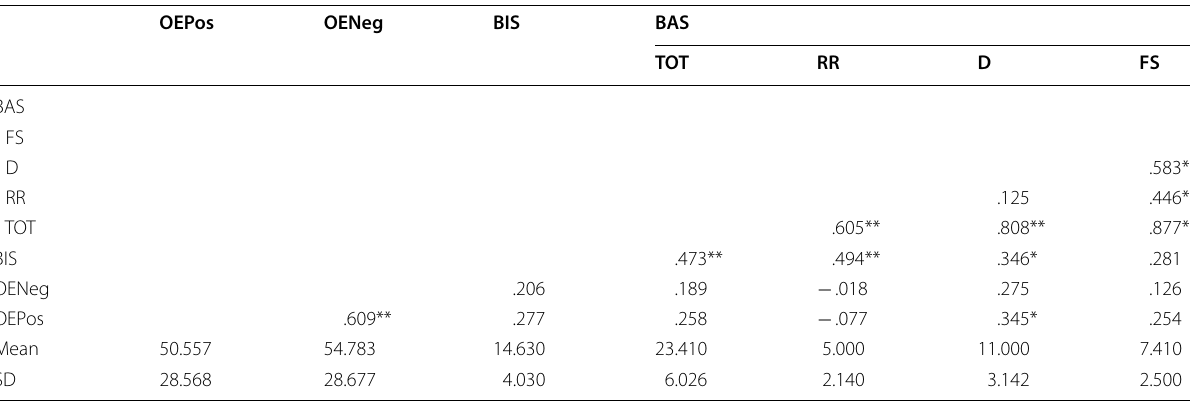
Table 2 Correlation matrix showing relationships between BIS Total, BAS Total, BAS subscales, and overestimation bias scores for women